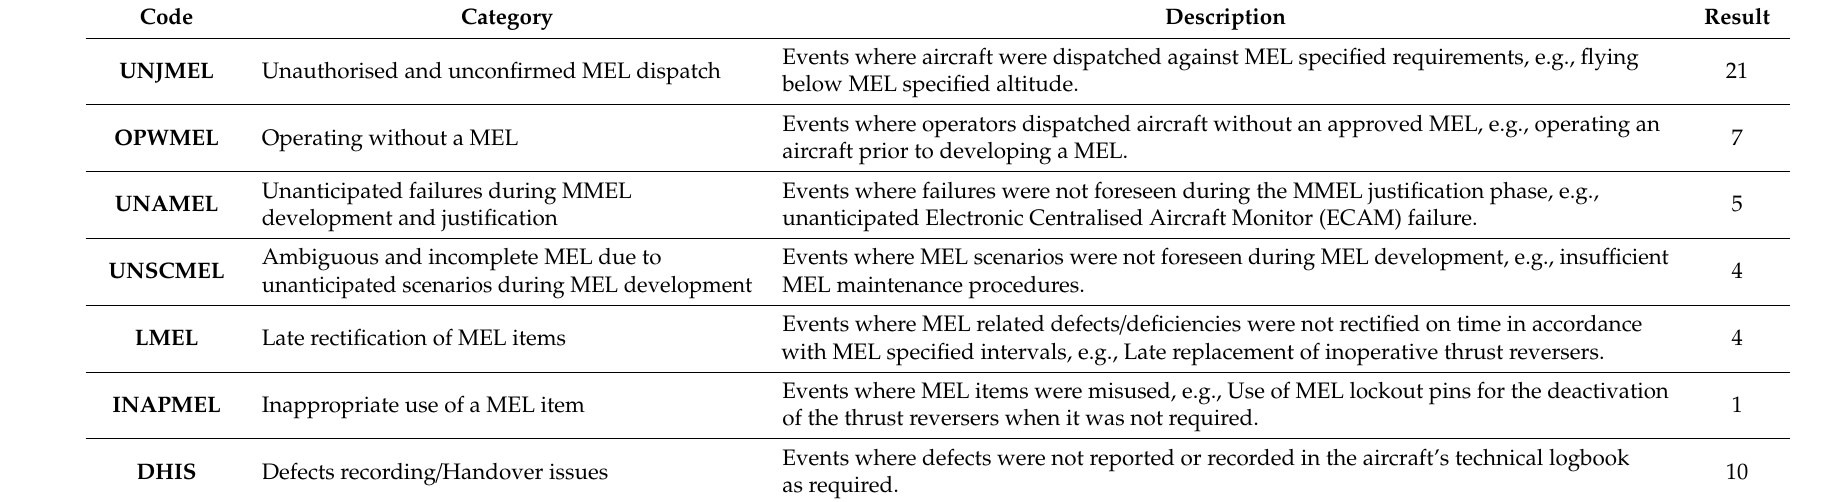
Table 5. MEL events